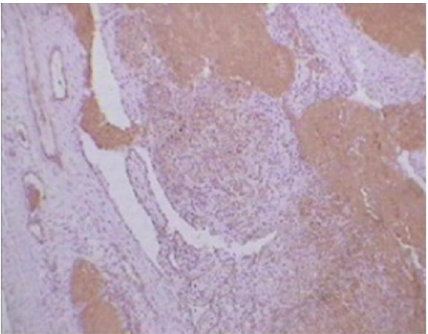
Figure 4: Immunohistochemical picture showing positivity for